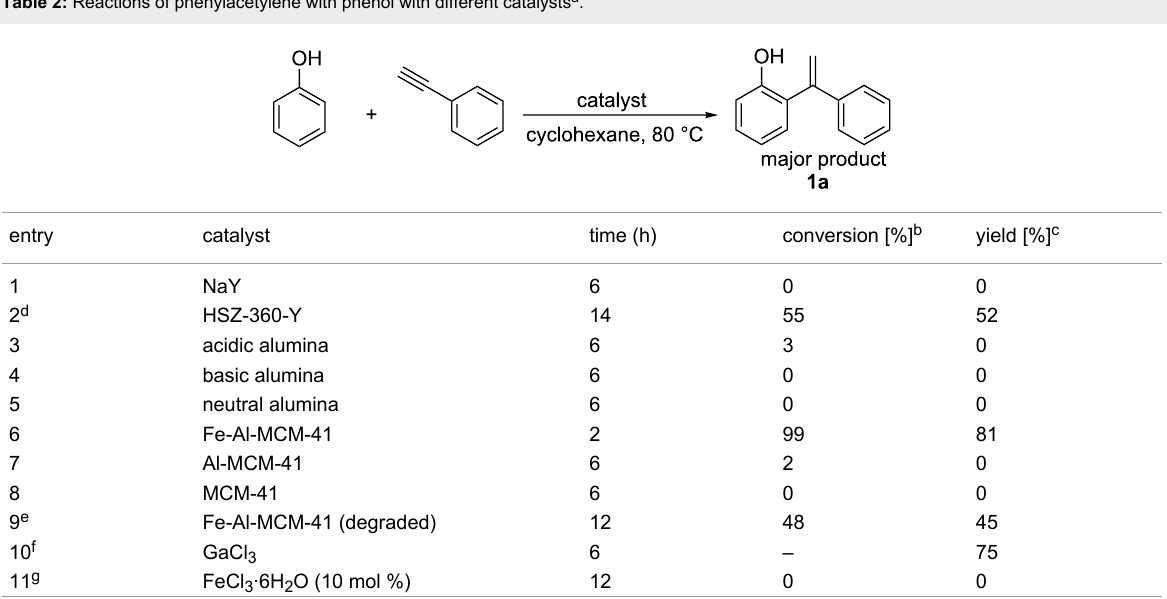
(under our reaction conditions) at a relatively low temperature (80 °C) without any pretreatment, no conversion was observed (Table 2, entry 3). The basic and the neutral alumina also remained inactive in catalyzing the coupling reaction (Table 2, entries 4 and 5). This may be attributed to the low